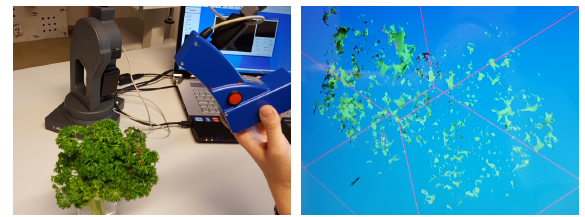
Figure 1. 3D data acquisition of Petroselinum crispum using laser light sheet triangulation.